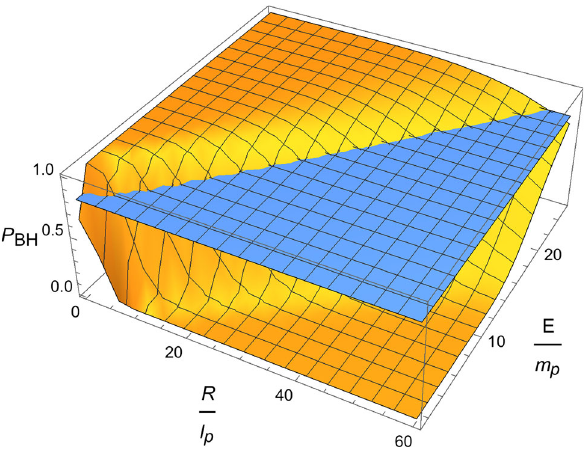
Fig. 6 Probability for two collapsing shells with momenta P 1 = − 5 P and P 2 = − P to form a black hole as a function of the radius R and the total energy E (in Planck units). The blue plane delimits the region where the probability P BH > 0 . 8